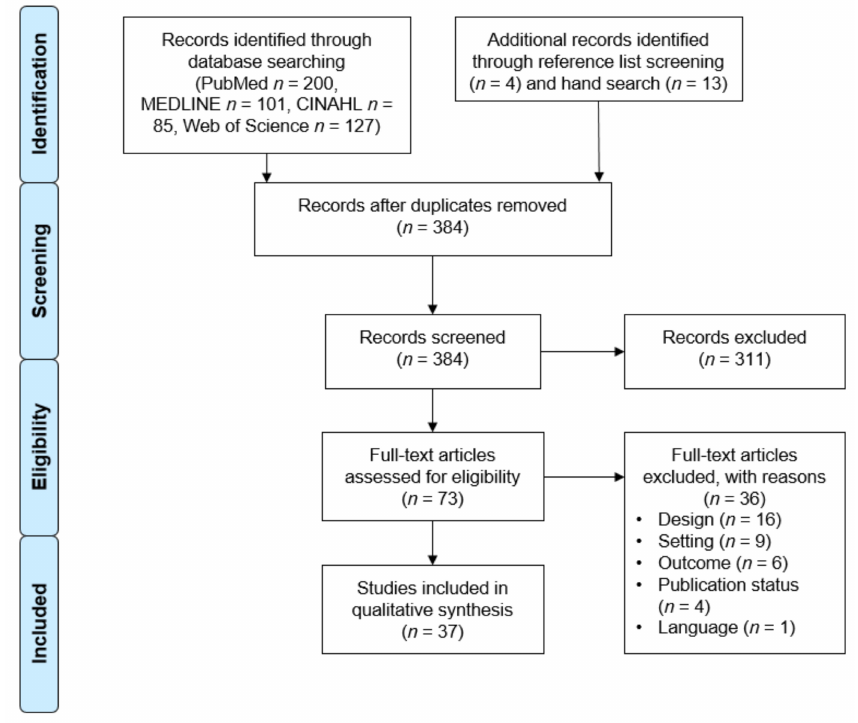
Figure 1. PRISMA Flow Diagram for the selection process of systematic reviews, following Moher et al.